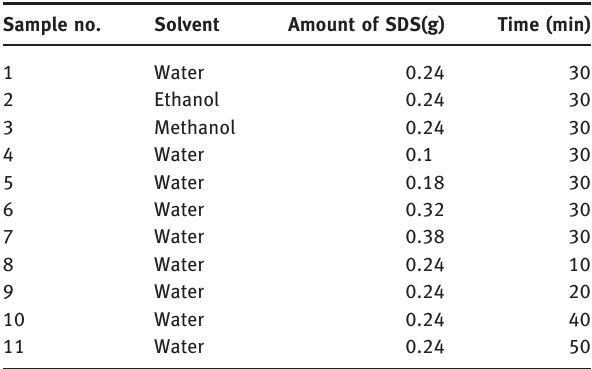
Table 1: The reaction conditions of MnOOH samples synthesized from [Mn(Hsal) 2 ]. Sample no.